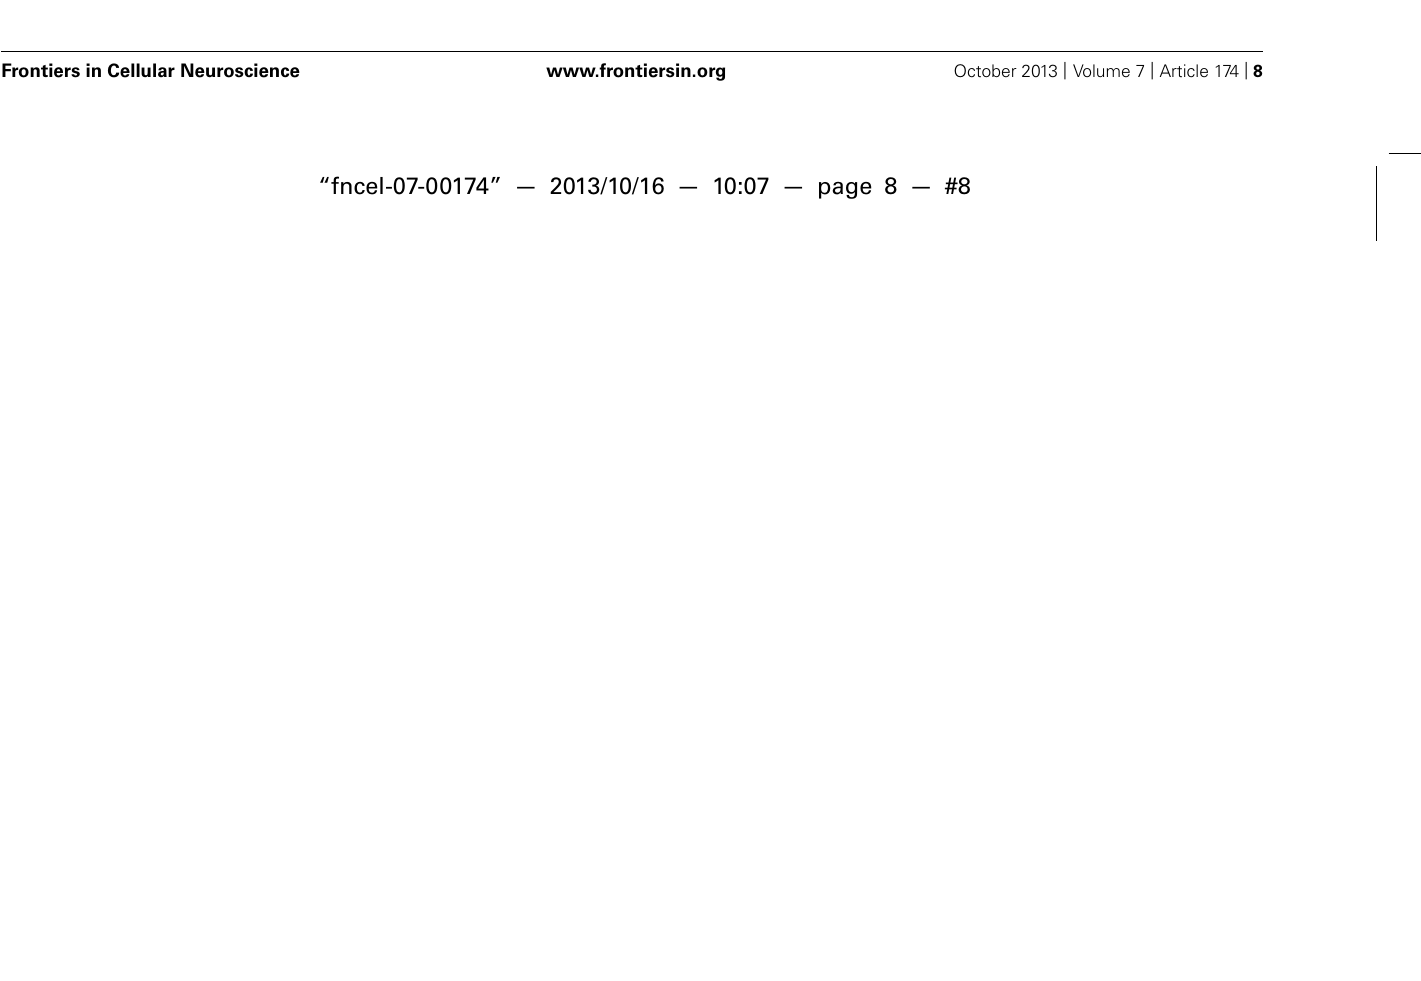
FIGURE 2 | Morphological characteristics of M1 layer 5 neurons grouped according to the projection target. (A) Grouped overlays of 5 single reconstructed neurons aligned at the pia (dashed line). One cell is highlighted in each group. Axons are not shown. The CSp neurons shown were labeled from the lumbar spinal cord but cellular morphologies are representative also for cervical projecting CSp neurons. (B) Sholl analysis of dendritic complexity with increasing radial distance from the soma center. Sholl radii were normalized by soma depth from the pia and multiplied again by the average soma depth of all cells across all groups ( † , the dashed line represents the sholl radius that equals soma depth from the pia), or by